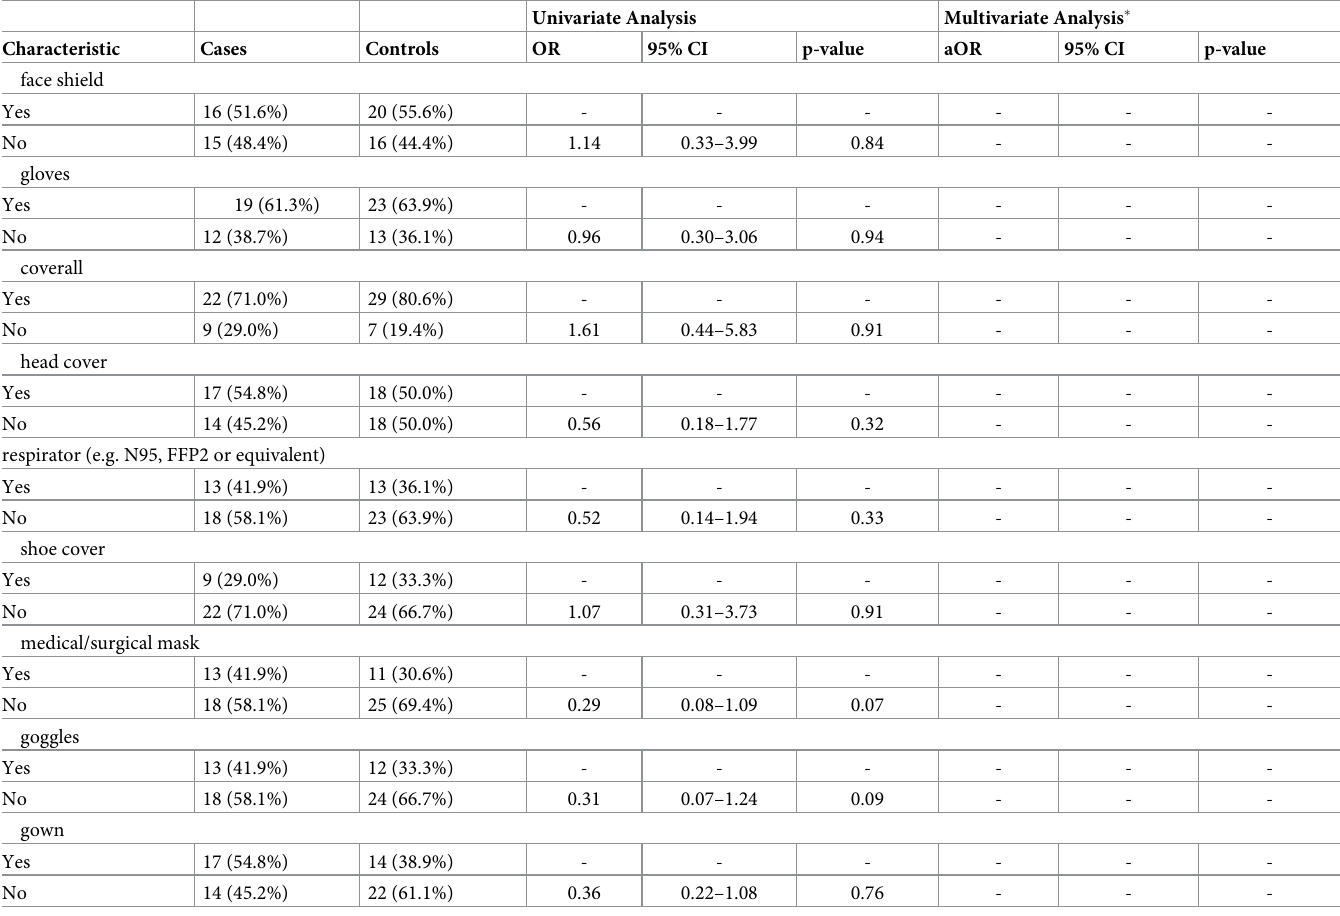
Table 3. Associations between PPE during prolonged close contact and COVID-19